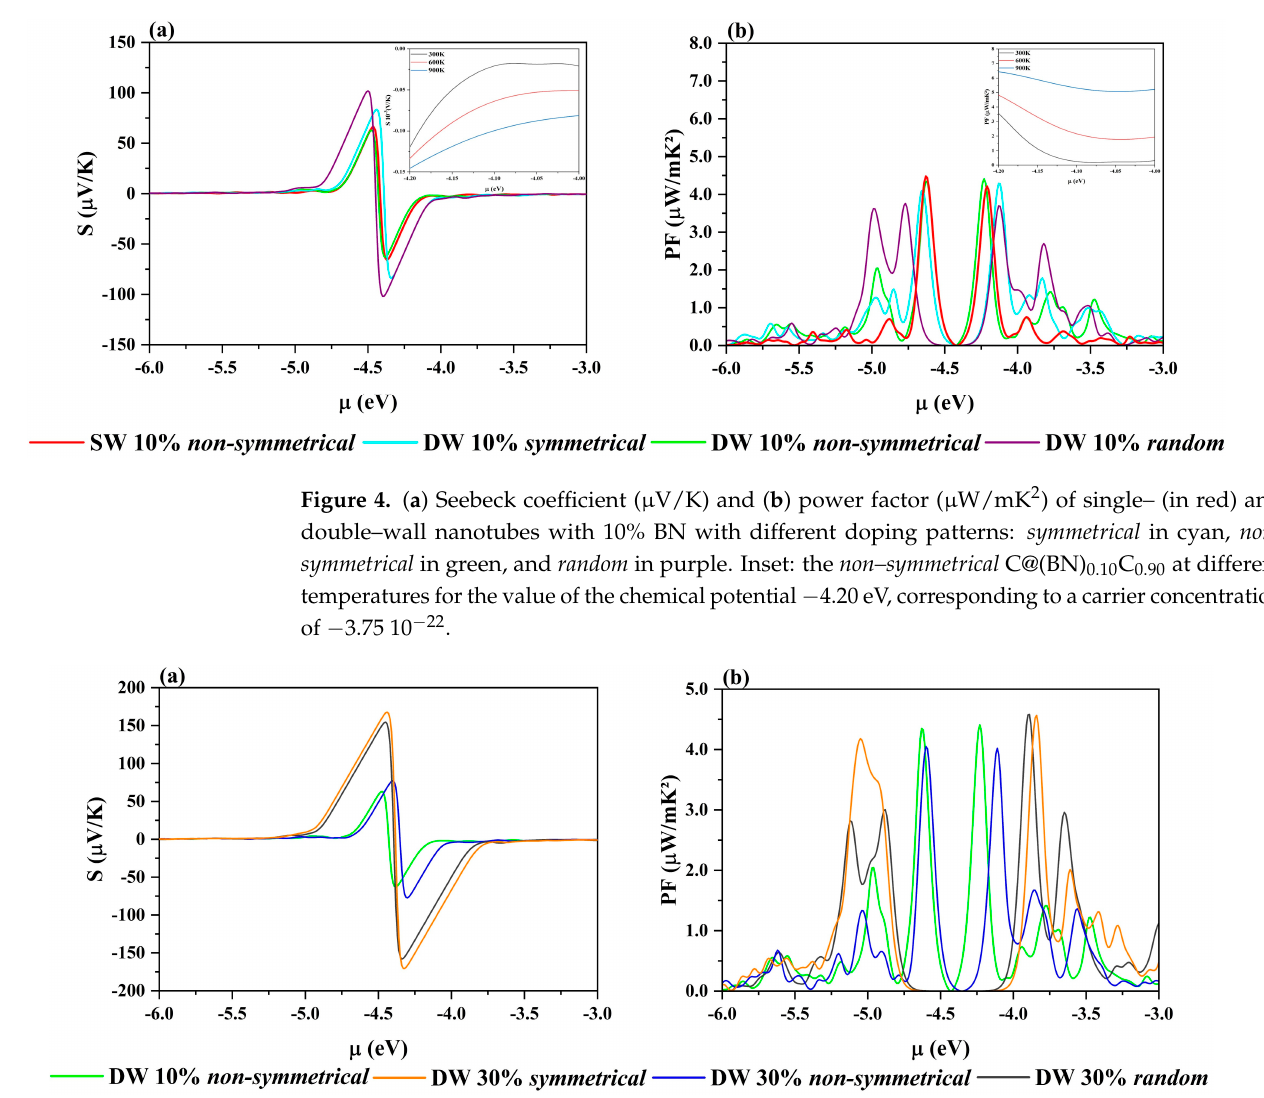
Figure 5. ( a ) Seebeck coefficient (µV/K) and ( b ) power factor (µW/mK 2 ) for 30% BN-doped DW structures, C@(BN) 0.3 C 0.7 . Symmetrical : orange; random : gray; non–symmetrical: blue. For the sake of comparison, the C@(BN) 0.10 C 0.90 non–symmetrical is also added, in green.